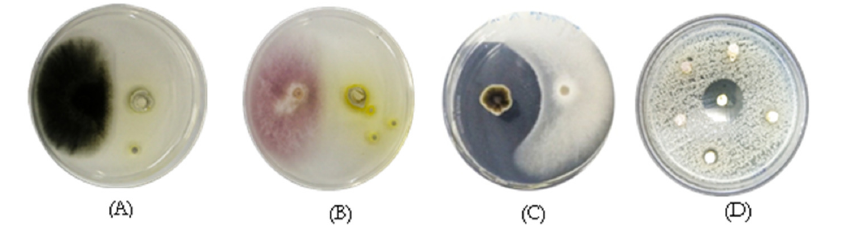
Figure 2. Figure 2.Figure 2. Figure 2. Antifungal and antibacterial activity of actinomycete isolates against phytopathogenic fungi and bacteria; (A): A. alternata ; ( B): F. oxysporum ; (C): F. solani ; (D): P.